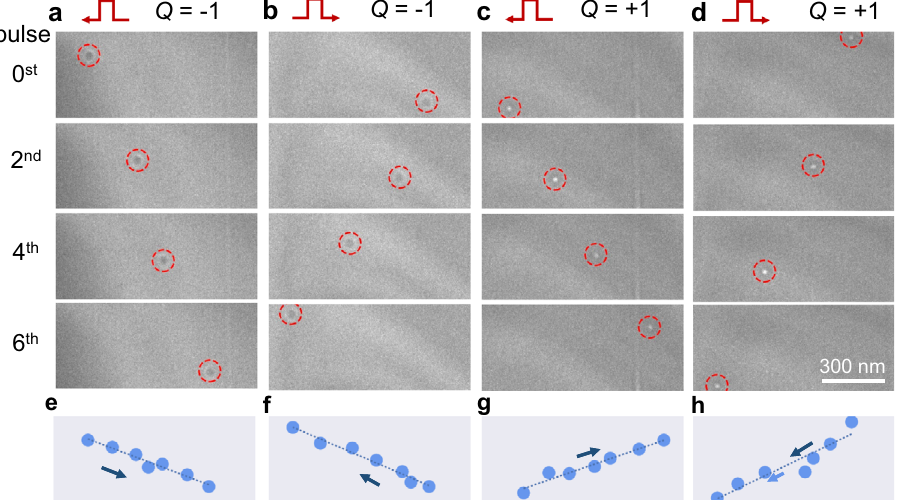
Fig. 3 Lorentz TEM imaging of a single skyrmion motion driven by current pulses. a A single skyrmion with Q ¼ (cid:1) 1 moves forward with a negative j < 0. b The reversal motion of skyrmion with Q ¼ (cid:1) 1 at j > 0. c A single skyrmion with Q ¼ þ 1 moves forward at j < 0 : d The reversal motion of skyrmion with Q ¼ þ 1 at j > 0. The corresponding trajectories of the skyrmion motion are shown in ( e – h ). The fi tted lines are shown to guide the eyes. The nonzero transverse motion in the + y direction is characterized by the skyrmion Hall angle, which depends on the skyrmion number while not the current direction. A negative (positive) Q is determined by the positive (negative) magnetic fi eld at B = 94 mT. The current density is j j j ¼ 3 : 48 ´ 10 10 A (cid:3) m (cid:1) 2 and the pulse width is 80 ns. The scale bars are 300